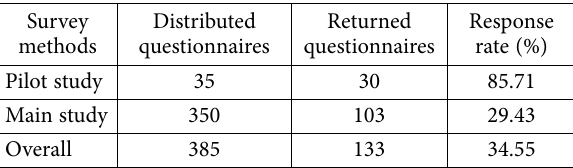
Table 2. Summary of response rates